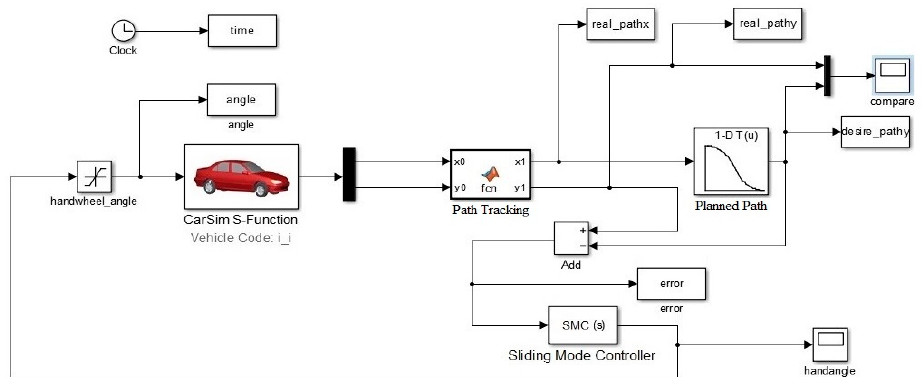
Figure 12. Parking Path Planning and Tracking Control Model.